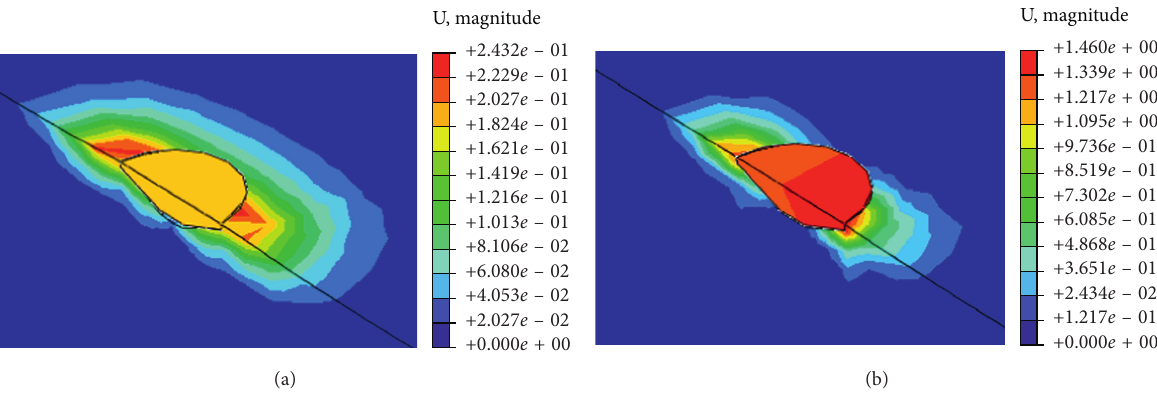
Figure 20: Deformation of the sand surrounding the CHFRF. (a) CHFRF without the rubber layer. (b) CHFRF with the rubber layer no. 4.